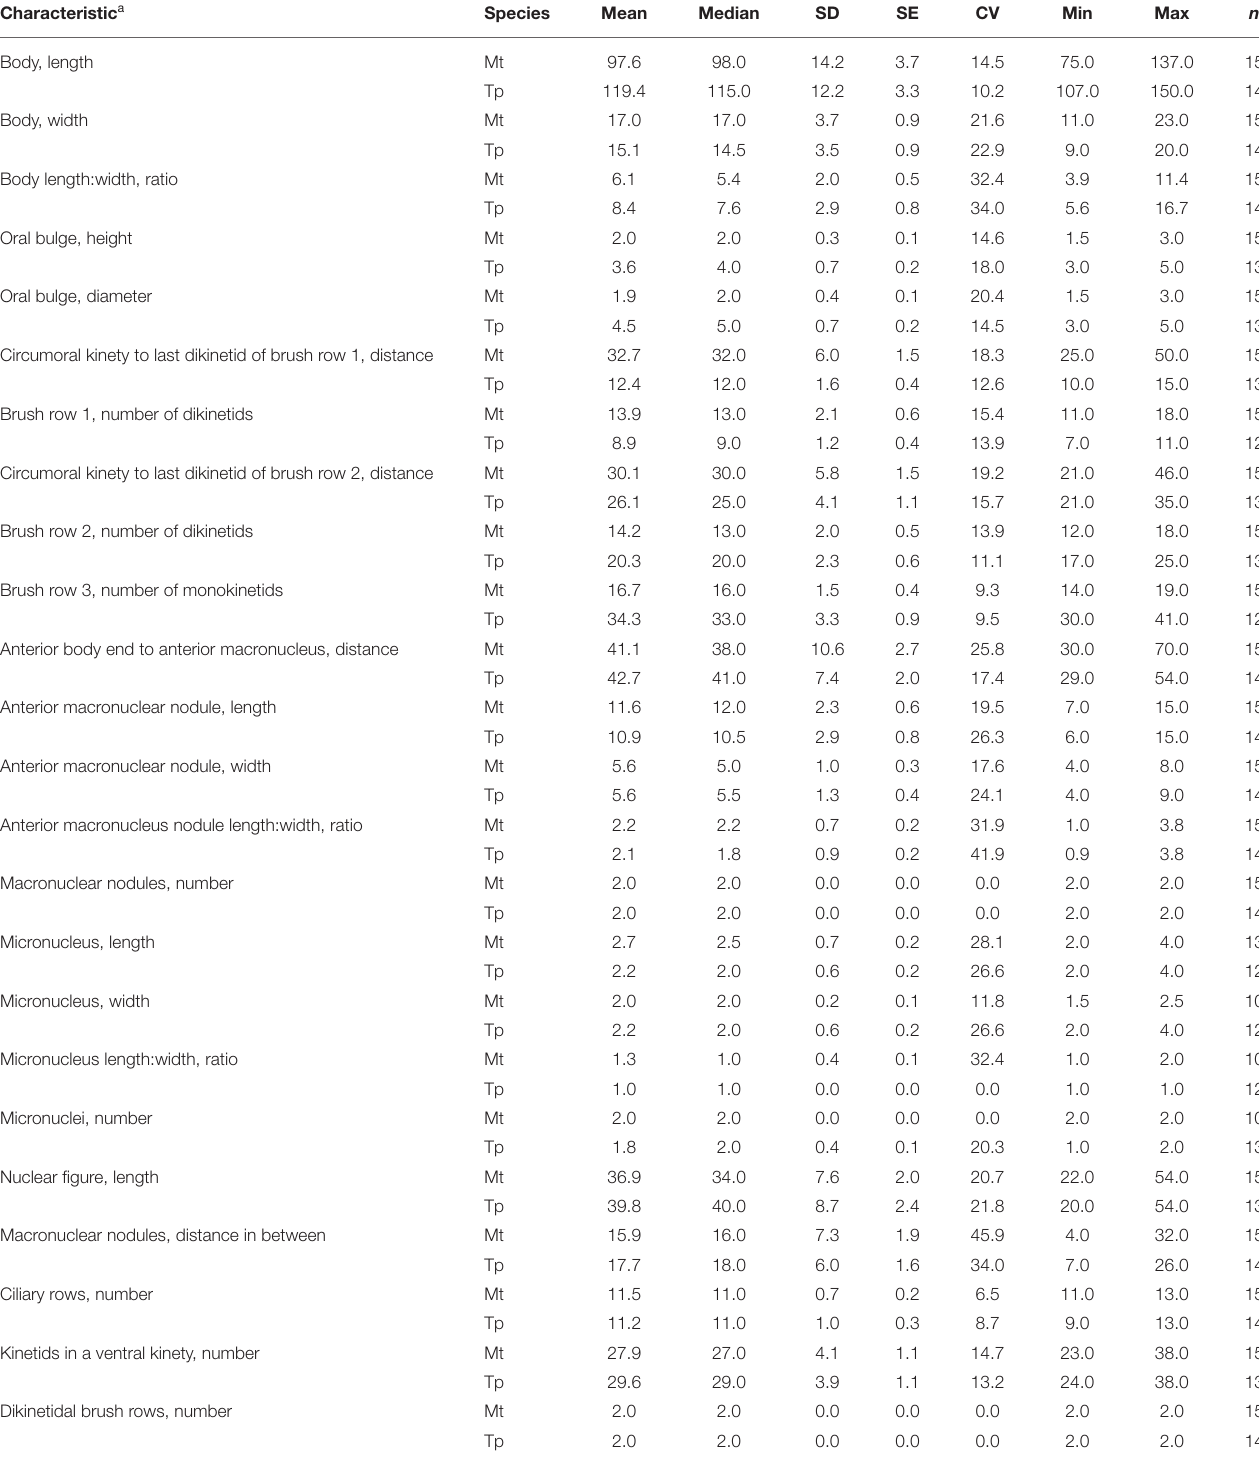
TABLE 1 | Morphometric data on Monolamellophrya terricola gen. nov., sp. nov. (Mt), and Trachylophyllum parapiculatum sp. nov. (Tp). Characteristic a Species Mean Median SD SE CV Min Max n Body, length